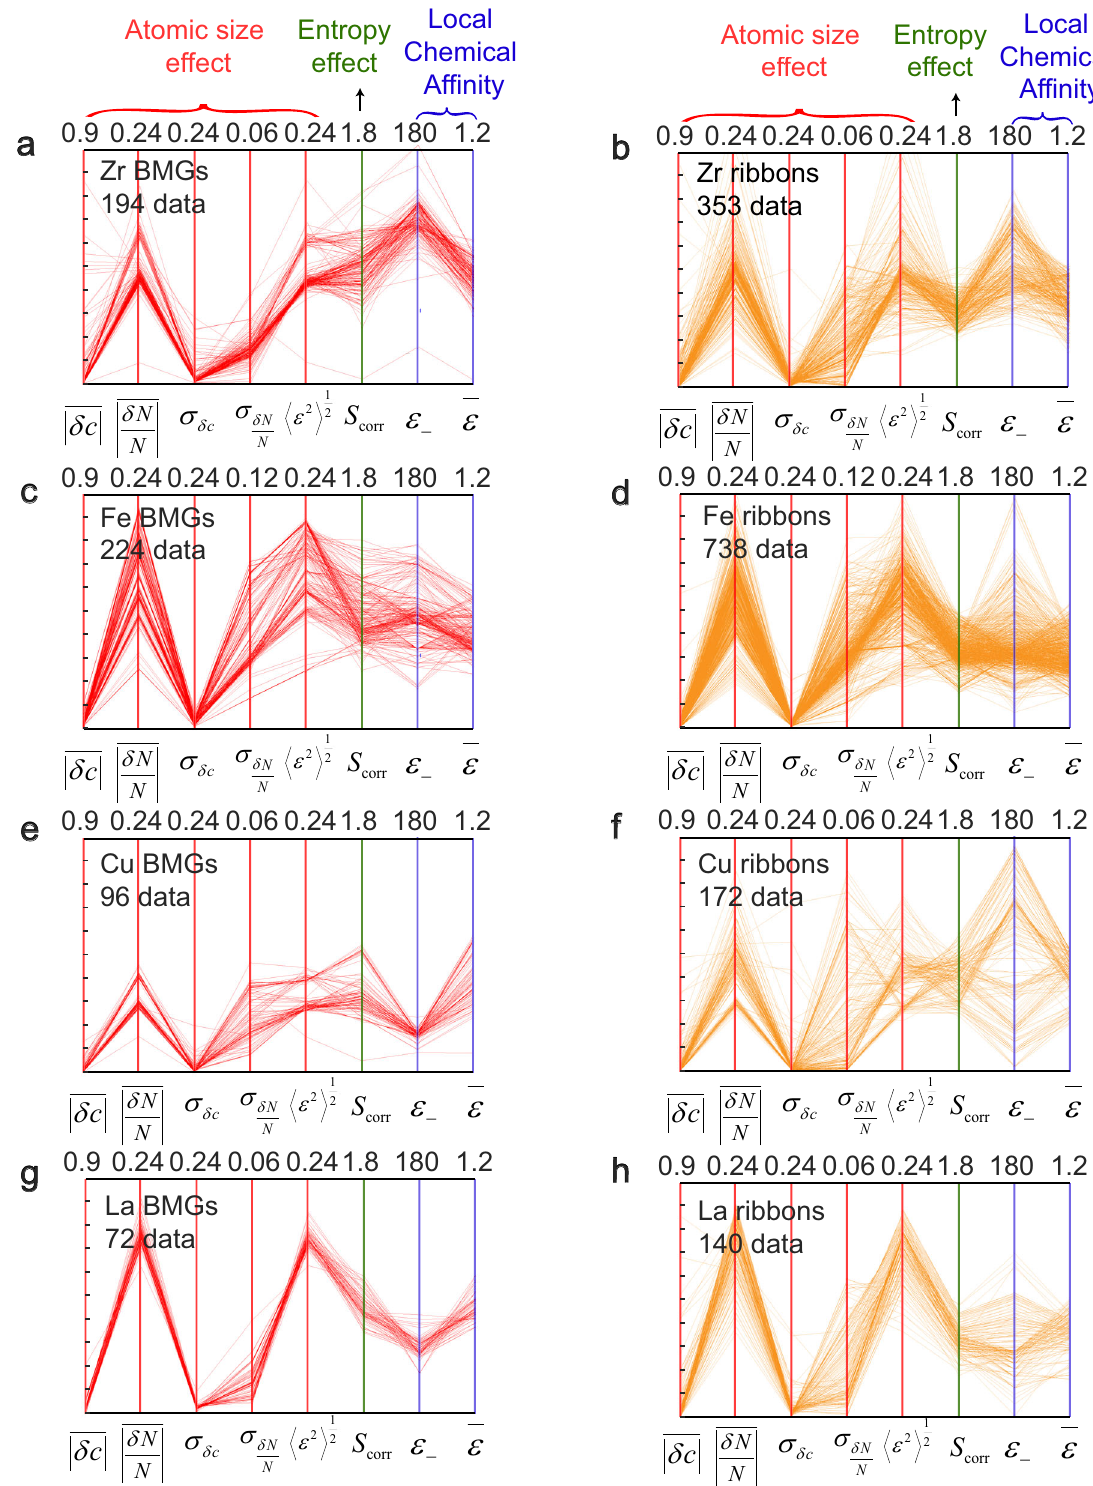
Fig. 6 Visualization of 8 features in different groups of compositions. Parallel coordinate plots of a Zr-based BMGs, b Zr-based glass ribbons, c Fe-based BMGs, d Fe-based glass ribbons, e Cu-based BMGs, f Cu-based glass ribbons, g La-based BMGs, and h La-based glass